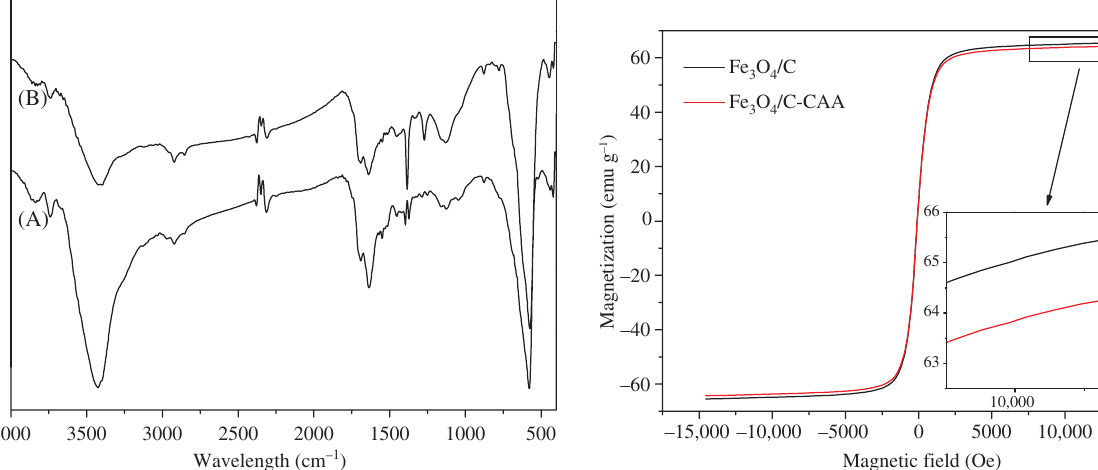
O /C (A) and Fe 3 4